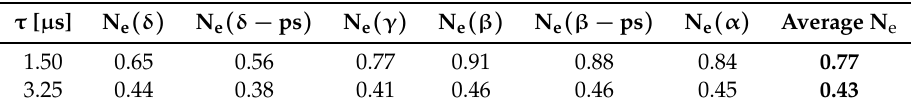
Table 2. First four Balmer-series electron densities, N e [ 10 17 cm − 3 ] , from line-of-sight data at 4.8-mm slit